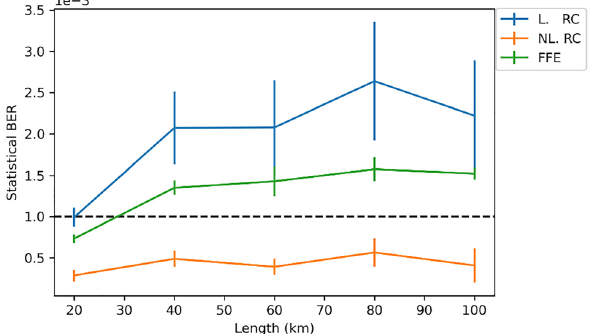
Figure 8: Testing BER versus link length for linear reservoir (blue) where no external nonlinearity is present, nonlinear reservoir (orange) where the KK receiver is leveraged as a nonlinear block, and an optical feed forward equalizer (green) for